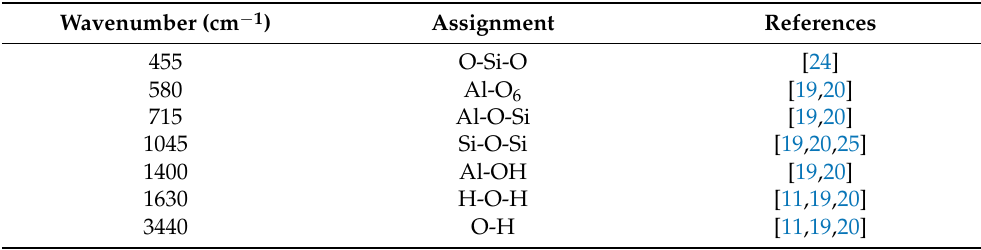
Table 2. IR transmittance wavenumber (cm − 1 ) and corresponding vibration bands of the synthesized aluminum silicate powder.